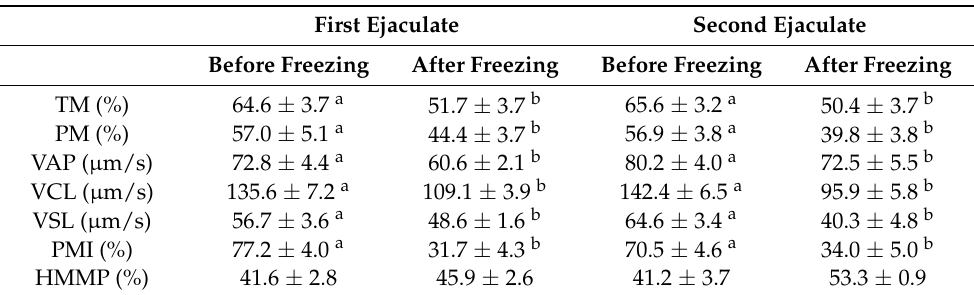
Table 12. Motility parameters and percentage of sperm with intact plasma membrane (PMI) and high mitochondrial membrane potential (HMMP) of the first and second ejaculates of the season collected from breeding inactive stallions (n = 20) before and after freezing.